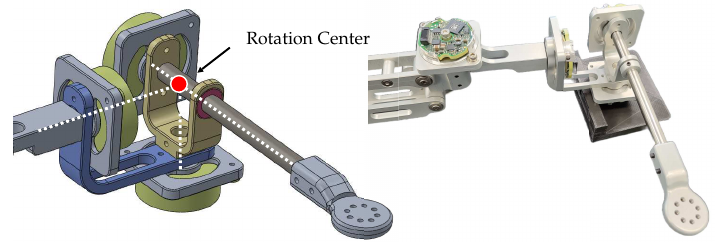
Figure 5. The rotational angle-tracking structure based on serial link mechanism.